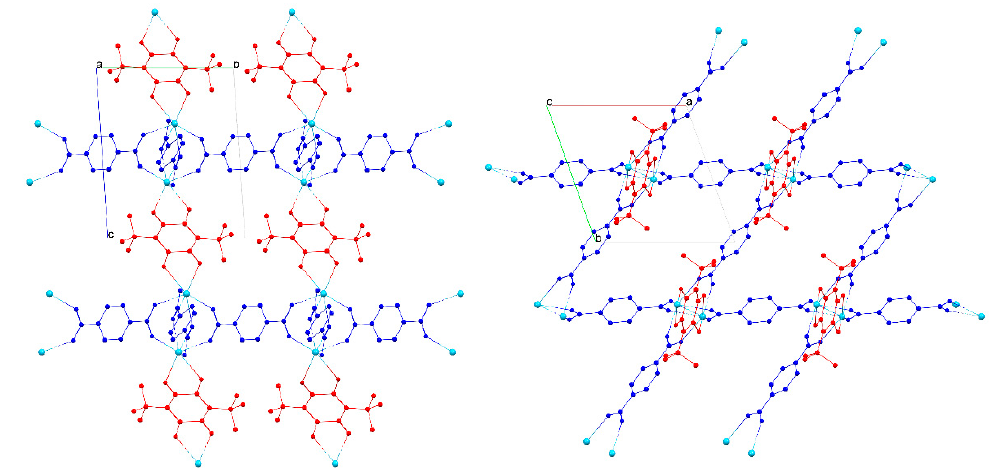
Figure 5. The fragment of crystal packing of 1 along the (100) (left) and (001) (right) vectors. DMF molecules are omitted for clarity. Color code: La, light blue; anilic ligands, red; dicarboxylate ligands, blue.